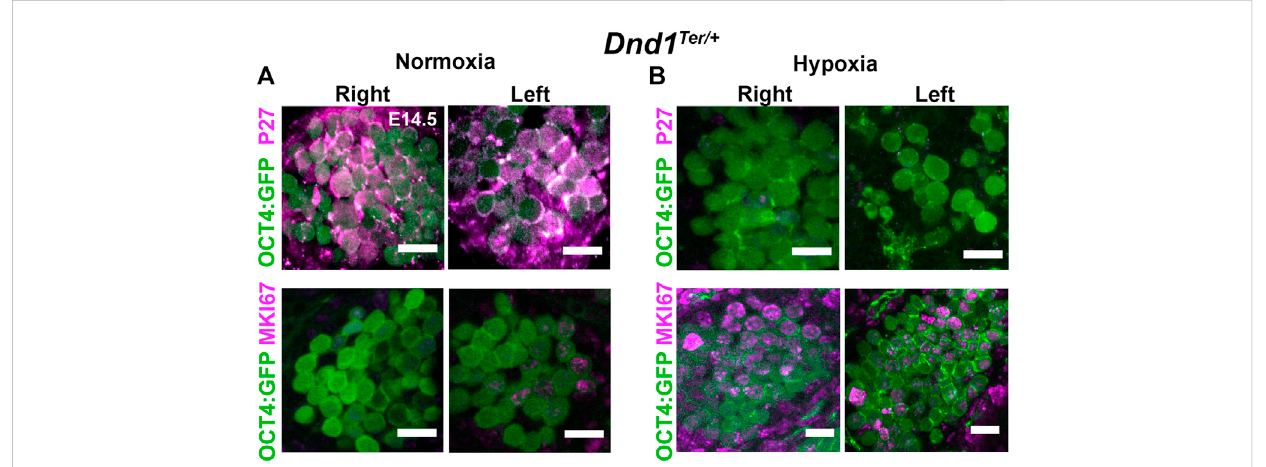
FIGURE 5 Exposure to hypoxia stimulates the cell cycle in germ cells. Pregnant females were exposed to hypoxia between E13.8 and E14.3. The hypoxic right (R) and left (L) gonads, together with normoxic controls, were disected at E14.5. Dnd1 Ter/+ :Oct4:GFP gonads where stained for MKI67 (an active cell cycle marker, magenta) or P27 (negative regulator of the cell cycle, magenta). (A) Under normoxic conditions, germ cells (OCT4+, green) enter G0/G1 arrest (p27 positive; MKI67 negative) (B) After hypoxic exposure, most germ cells (green) remain in active cell cycle at E14.5 (P27 negative; MKI67 positive, red). Representative image of n = 3 experiments. Scale bar 10